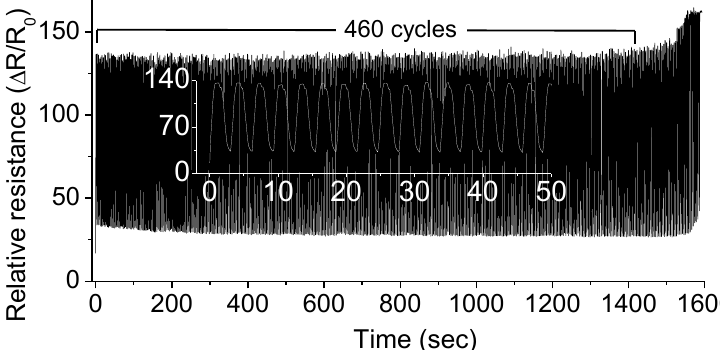
the strain range of 150%–500%. (Inset image: the first 16 full cycles carried out over a time period of 48.6